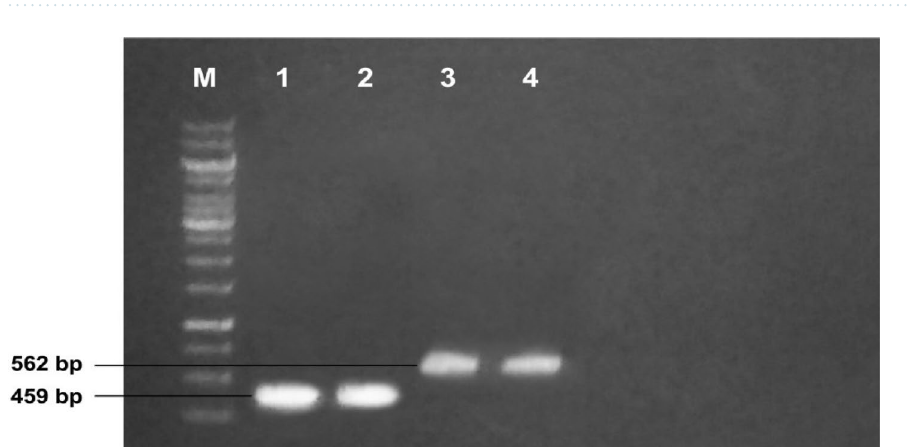
Figure 3. PCR amplification of both cry genes from transformed A. tumefaciens with the corresponding pCAMBIA1301- cryCassette constructions. M: 10 kb molecular weight marker, Lanes 1, 2: show cry3Bb1 gene, Lane 3, 4: show cry3 gene.